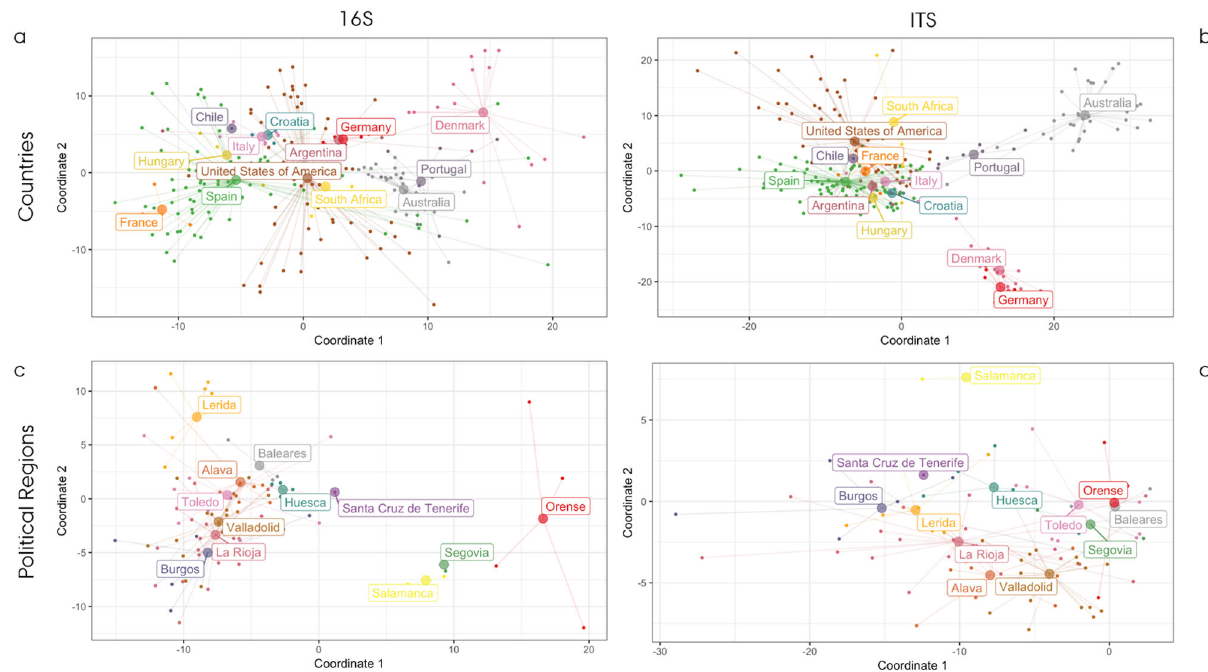
Fig. 3 PCoA plots of beta diversity based on CLR. Fig. 3a, b represent the national-scale samples ordination for prokaryotes ( a ) and fungal communities ( b ); Fig. 3c, d represent the national-scale samples ordination for prokaryotes ( c ) and fungal communities ( d ) on a subset of samples from Spain.